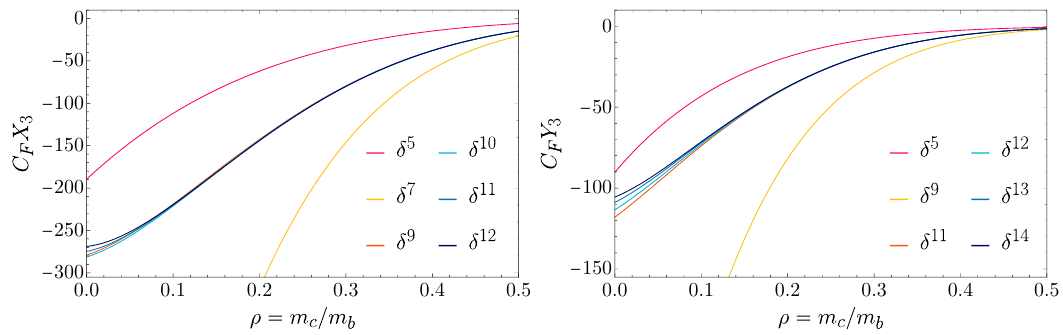
) contribution to the total decay rate b → s (cid:96)ν (left) and its first Figure 2: The O ( α 3 s q 2 -moment (right) for different expansions depths in δ